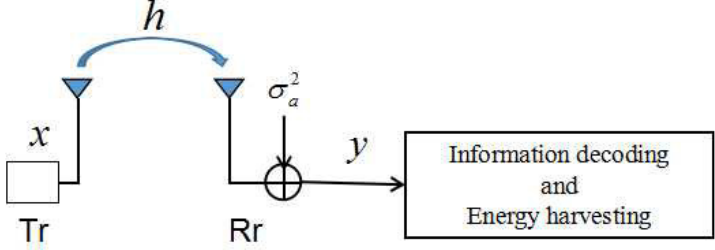
Figure 1. A practical transceiver design for the SWIPT